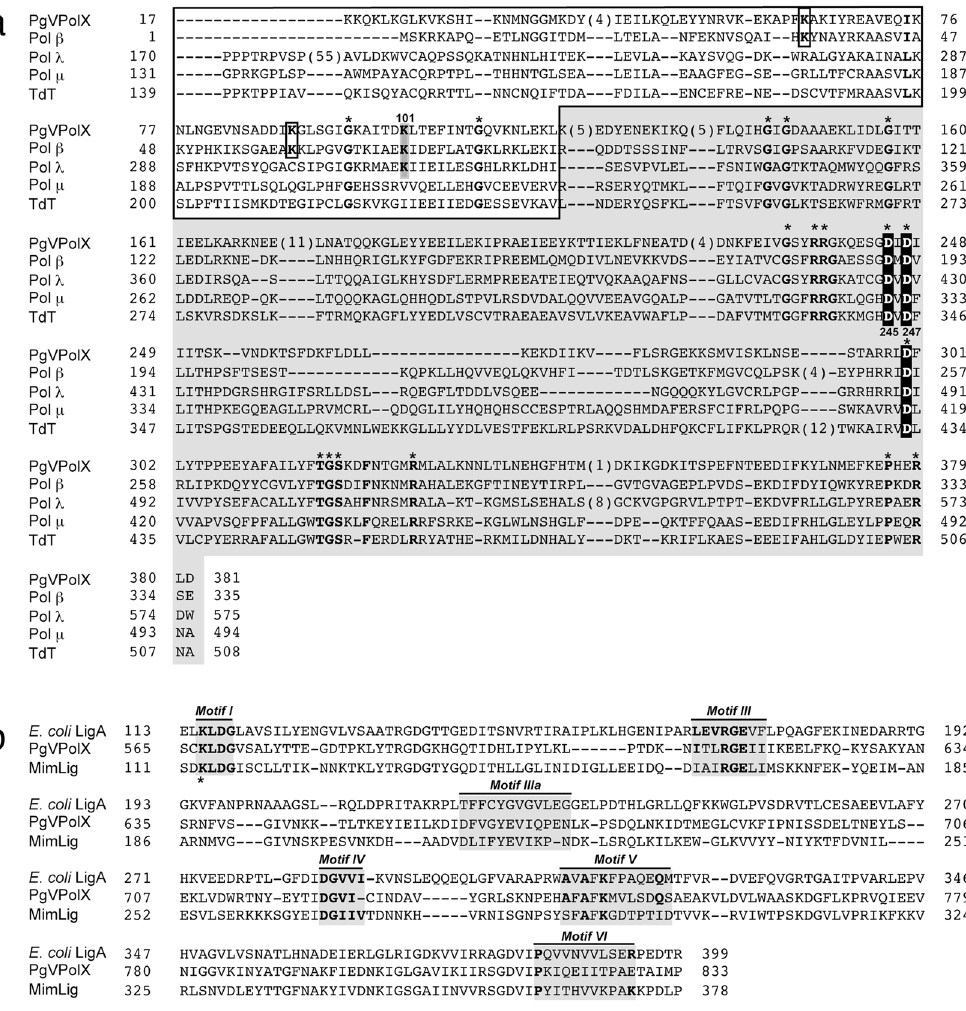
DNA synthesis following the Watson-Crick base pairing rules as it extended the primer strand exclusively in the presence of the complementary (correct) nucleotide despite a 10-fold higher concentration of each of the three non-complementary (incorrect) deoxynucleotides. To evaluate 3 ′ - and 2 ′ -OH discrimination by PgVPolX, we used a defined 1-nt gapped DNA molecule to compare dGMP, ddGMP and GMP incorporation. As shown in Fig. 4b, the enzyme inserted dGMP and ddGMP nucleotides with a similar efficiency, suggesting that PgVPolX does not show a strong selection for the 3 ′ -OH group of the nucleotide. Similar to that observed for Pol β and Pol λ , PgVPolX was severely impaired in its ability to incorporate ribonucleotides, most likely due to the presence of the aromatic residue Tyr315 (see Fig. 1a), which is a homolog of residues Tyr271 and Tyr505 of Pol β and Pol λ , respectively, and has been described to discriminate against the ribose 2 ′ -OH group 40, 41 .